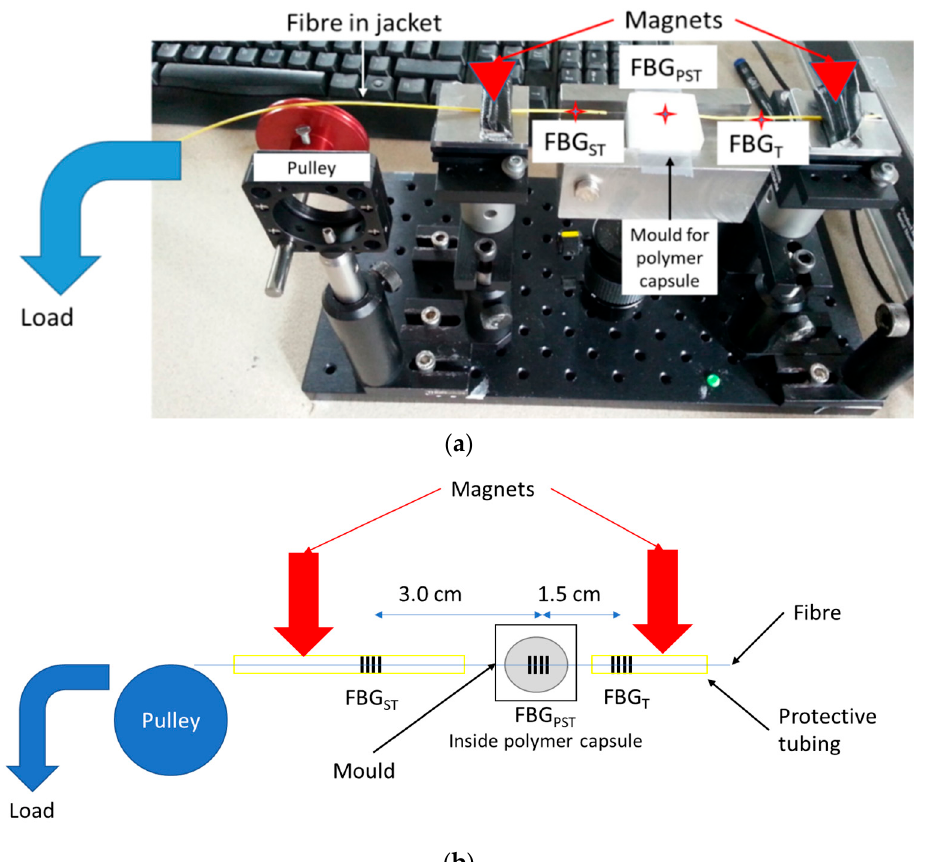
Figure 3. Experimental setup for testing the strain response of the fibre. The mould provides an anchor point to isolate FBG T from the effects of strain, the magnets hold the yellow protective tubing in place and the rest of the fibre can slide within the yellow jacket. ( a ) Labelled photograph; ( b ) labelled schematic.